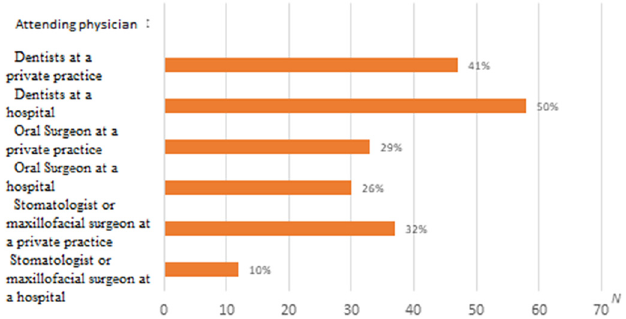
Fig. 4. Practitioners to whom antithrombotic patients were referred for oral surgery procedures at high hemorrhagic risk.